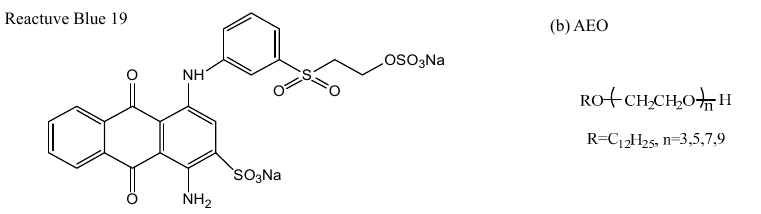
Figure 1. Structure of reactive blue 19 and AEO.